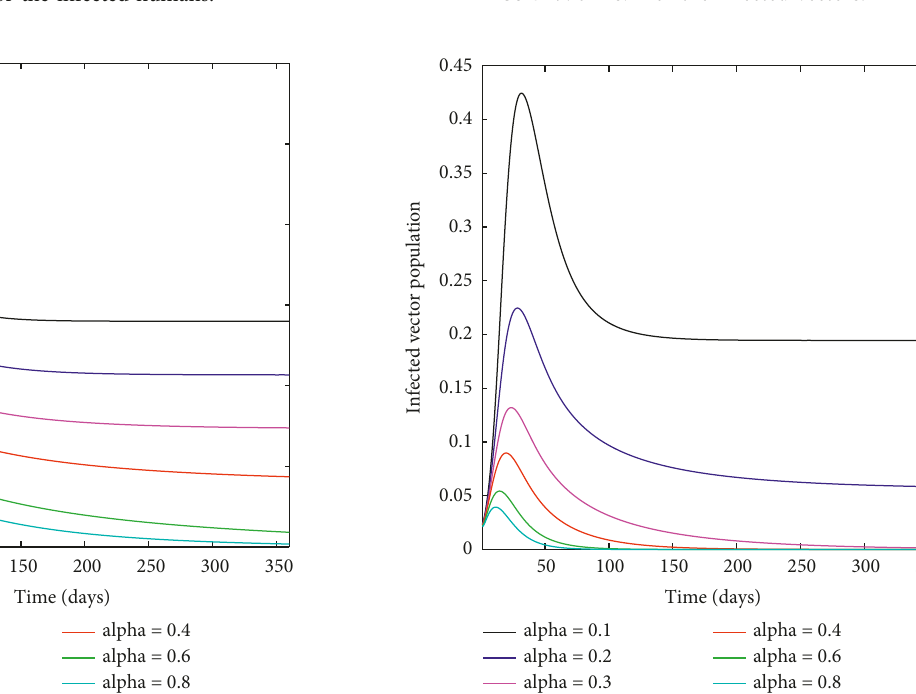
Figure 7: c � 0 . 1 for the infected vectors.